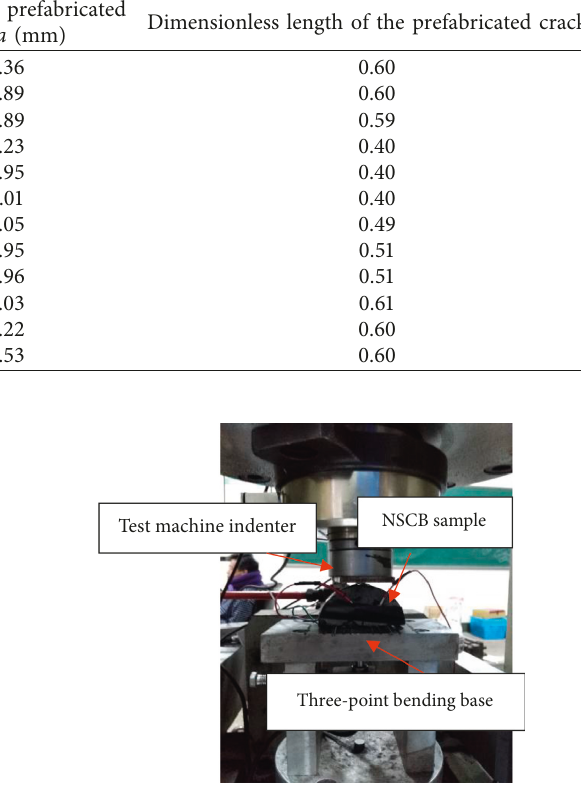
Figure 3: Fracture test diagram of the NSCB